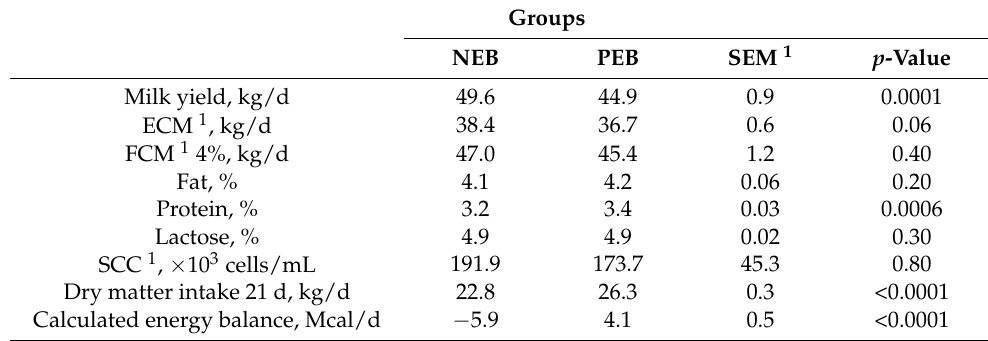
Table 1. Milk production and composition, dry matter intake, and the calculated energy balance of negative energy balance (NEB) and positive energy balance (PEB) cows during the first 45 d in